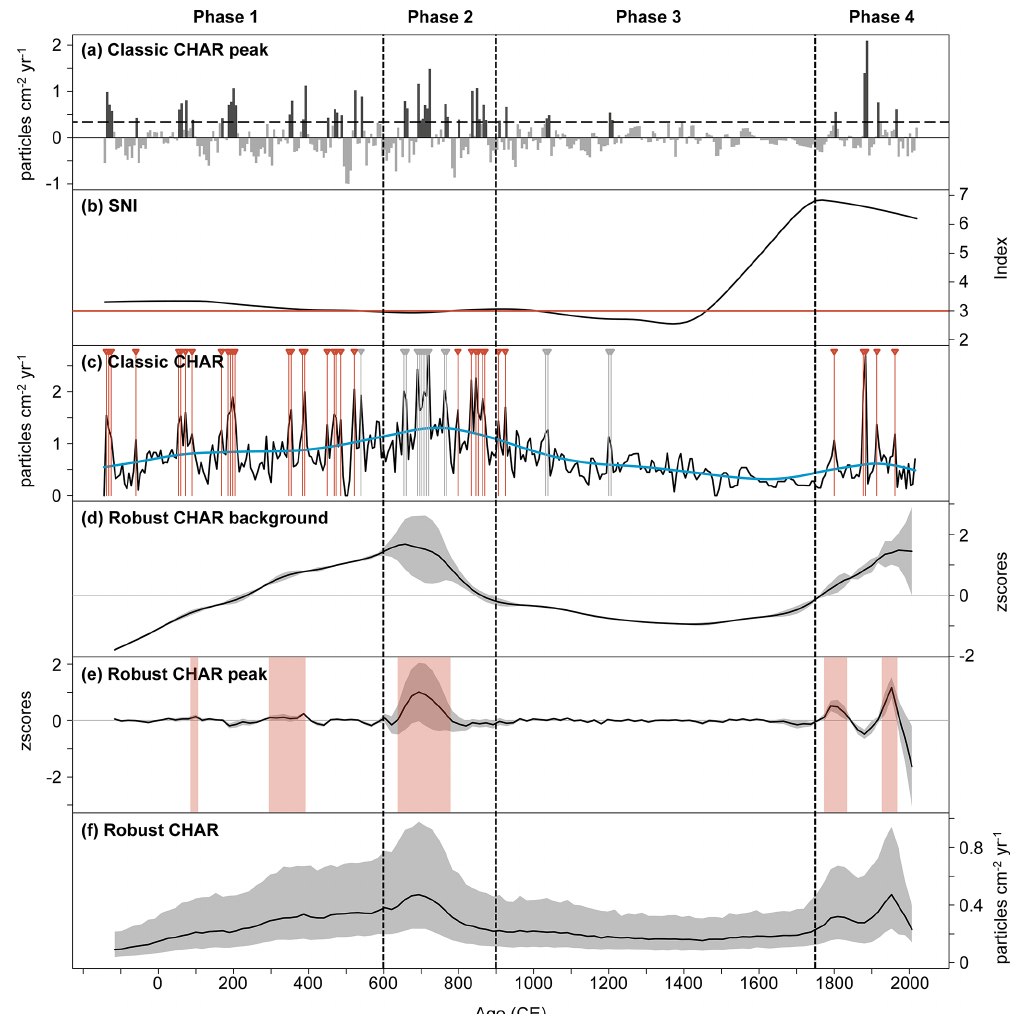
Figure 3. Overview of the charcoal record using classic and robust analysis approaches. Vertical dashed lines mark the different phases of the fire regime. (a) Classic CHAR peak component (dark-grey bars = signal, light-grey bars = noise, dashed horizontal line = threshold). (b) Signal-to-noise index (SNI) of the classic CHAR peak component based on Kelly et al. (2011) (red horizontal line = SNI cut-off value of 3). (c) Classic CHAR sum (black line = interpolated CHAR; blue line = LOESS representing the CHAR background com- ponent; red vertical lines = fire episodes with SNI > 3; grey vertical lines = fire episodes with SNI < 3). (d) Robust CHAR background component. (e) Robust CHAR peak component (red areas = above-average values). (f) Robust CHAR sum. For (d) – (f) , black line = median and grey area = interquartile